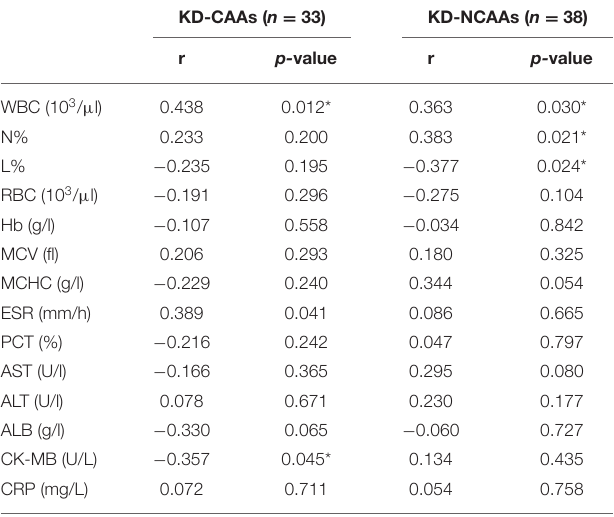
TABLE 3 | Correlations between serum Lp-PLA2 levels and general laboratory variables in KD-CAAs and KD-NCAAs groups. KD-CAAs ( n =